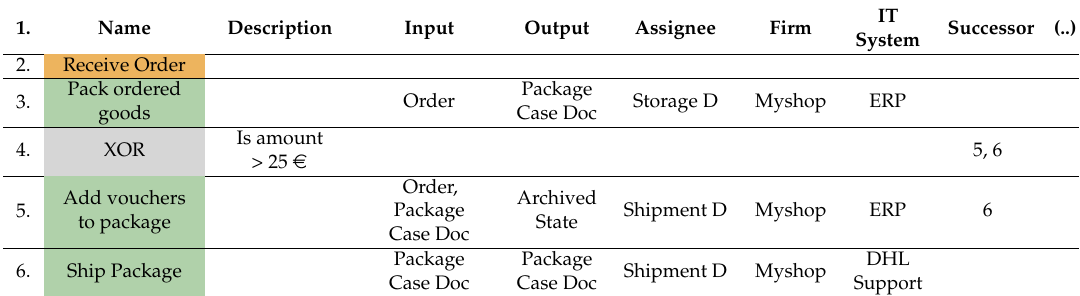
Table 1. An example of a spreadsheet-based process model from